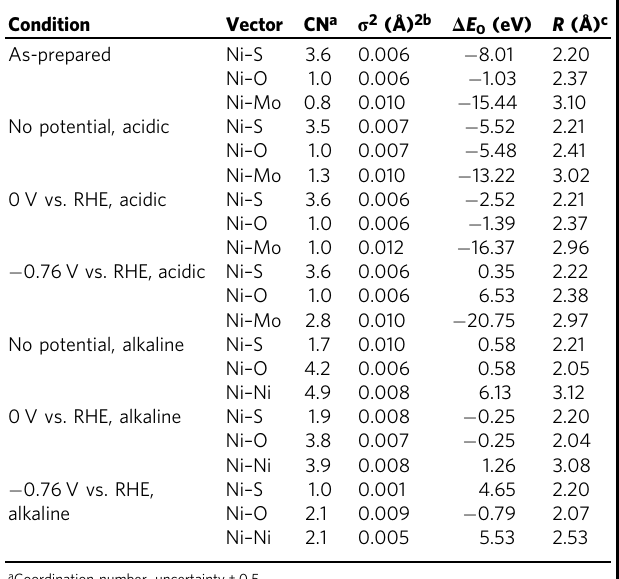
Table 1 FEFF fi tting parameters for Ni – K edge in situ XAS